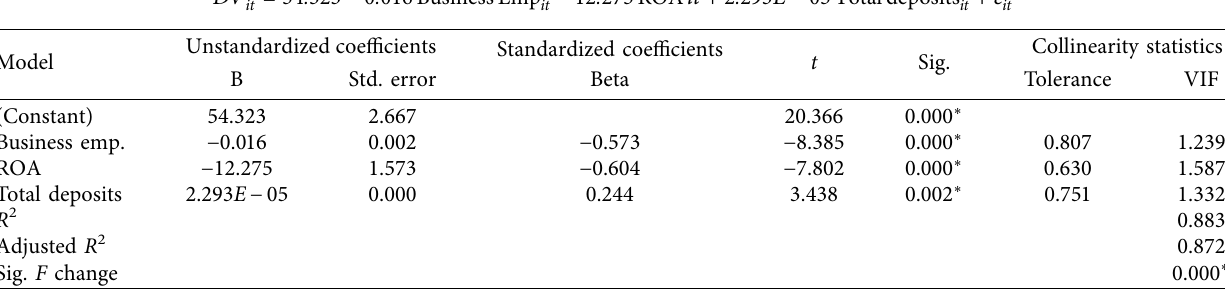
Table 3: Summary of conventional banks’ efficiency model.